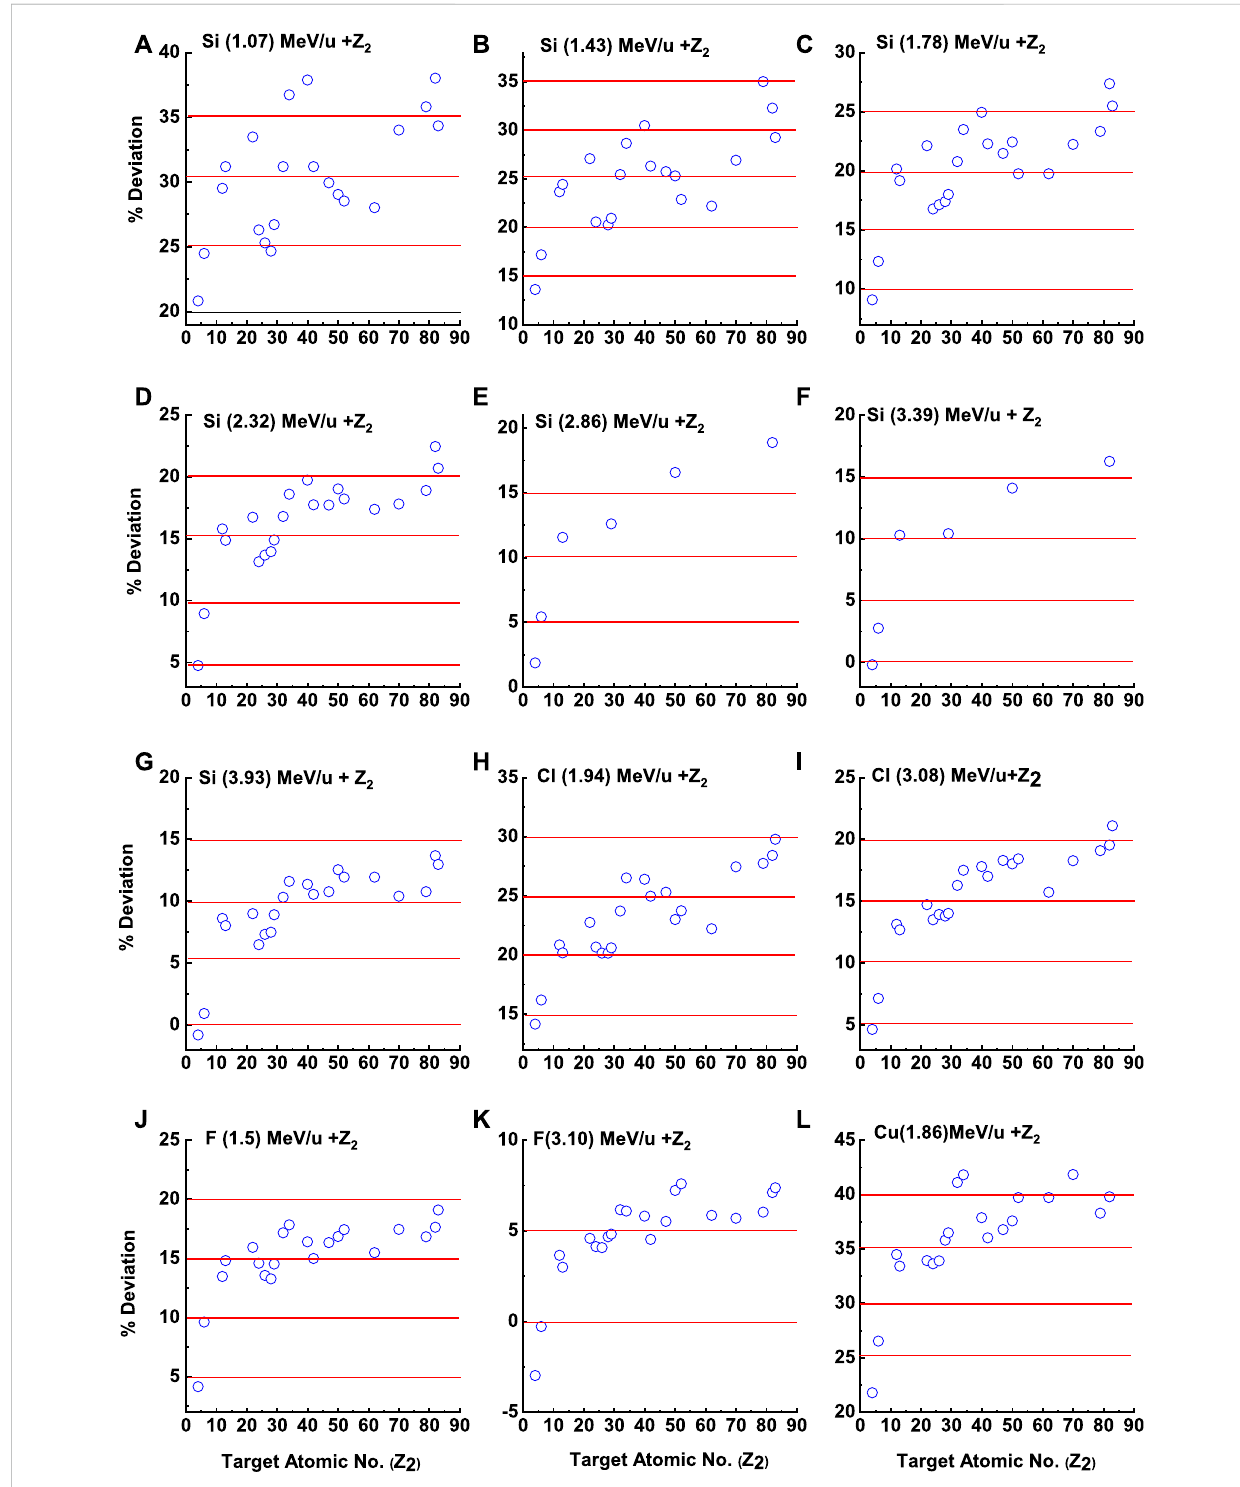
FIGURE 6 Comparison of the percentage of deviation of the F-G-M model and the experimental mean charge state (cid:1) q as a function of Z 2 (A-L) .